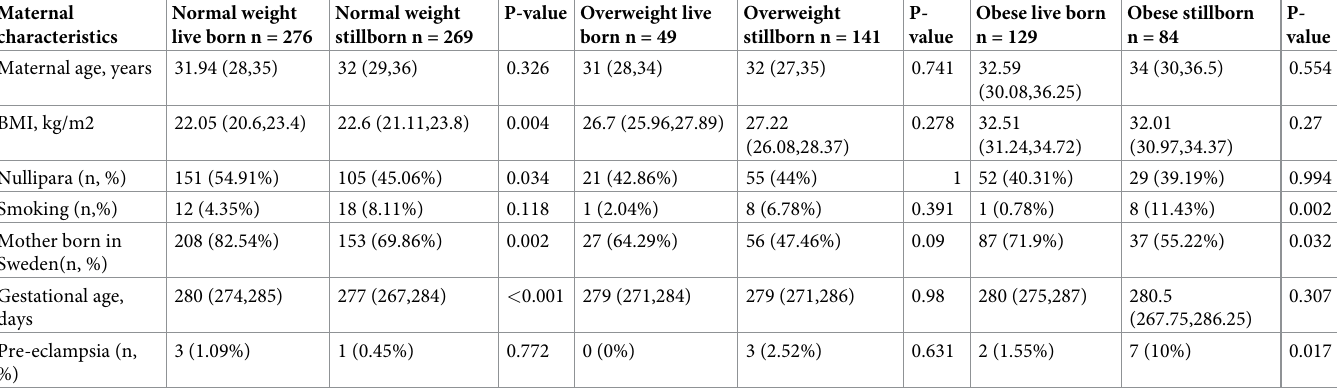
Table 1. Maternal characteristics comparing term pregnancies with live born infants with term pregnancies complicated by stillbirth, according to pre-pregnancy BMI in Stockholm county 2002–2018. For continuous variables medians with interquartile range are expressed and for categorical variables numbers and proportions are